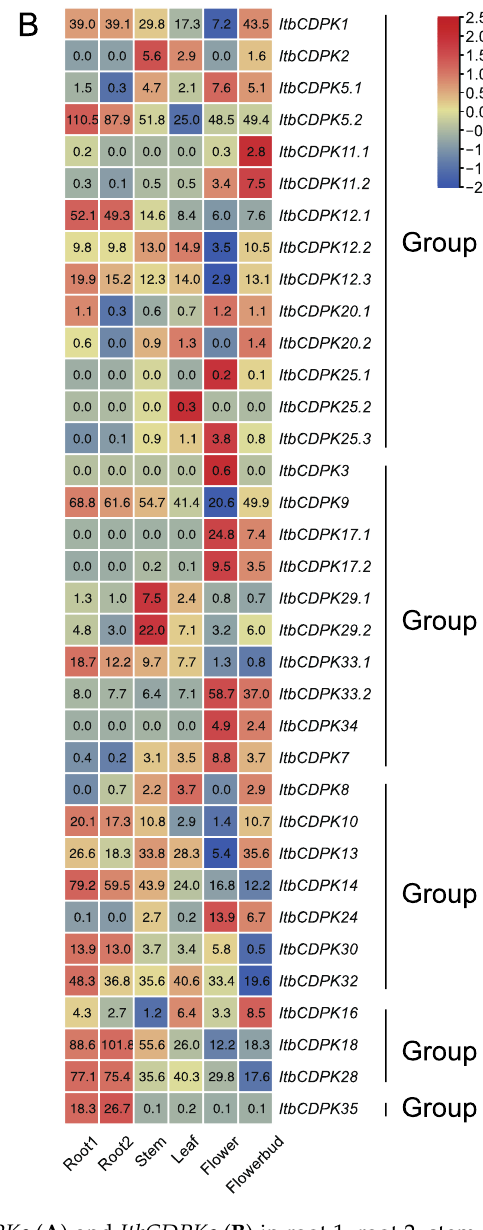
Figure 7. Gene expression patterns of ItfCDPKs ( A ) and ItbCDPKs ( B ) in root 1, root 2, stem, leaf, flower and flower bud of I. trifida as determined by RNA-seq. Log 2 (FPKM + 1) is shown in the boxes.